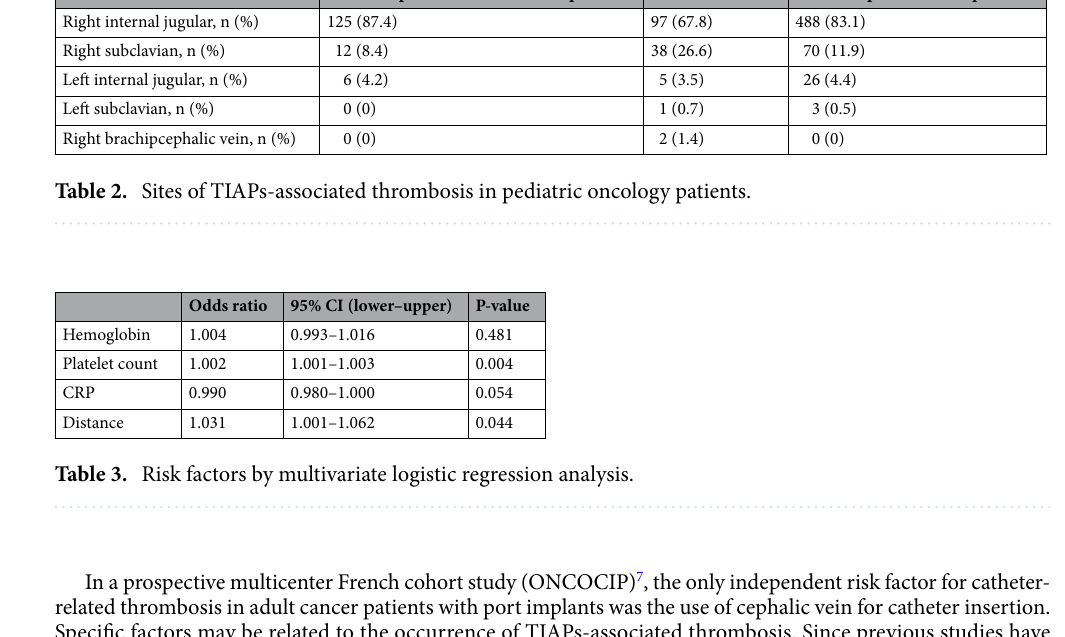
Insertion position of thrombosis patients Site of thrombus Insertion position of all patients Right internal jugular, n (%)